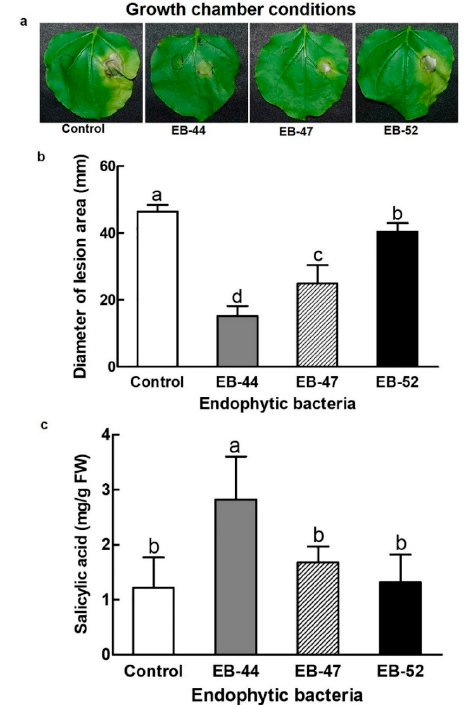
Figure 2. Disease resistance against Pseudomonas syringae pv. tabaci ( Pst ) and salicylic acid (SA) concentrations in the leaves of Nicotiana benthamiana grown from seeds treated with 10 mM MgCl 2 (control), EB-44, EB-47, or EB-52 for 3 h. ( a , b ) The leaves of 4-week-old plants were infiltrated with 0.1 mL of Pst and the diameters of the infected areas were measured 6 days post inoculation. Left: 10 mM MgCl 2 as control; right: 0.1 OD 600 Pst . ( c ) The concentrations of SA in the leaves were measured before Pst infiltration. Data represent means ± standard deviations of four independent replications for each treatment. Means with different letters are significantly different at p < 0.05 by Duncan’s multiple range test. FW = fresh weight.